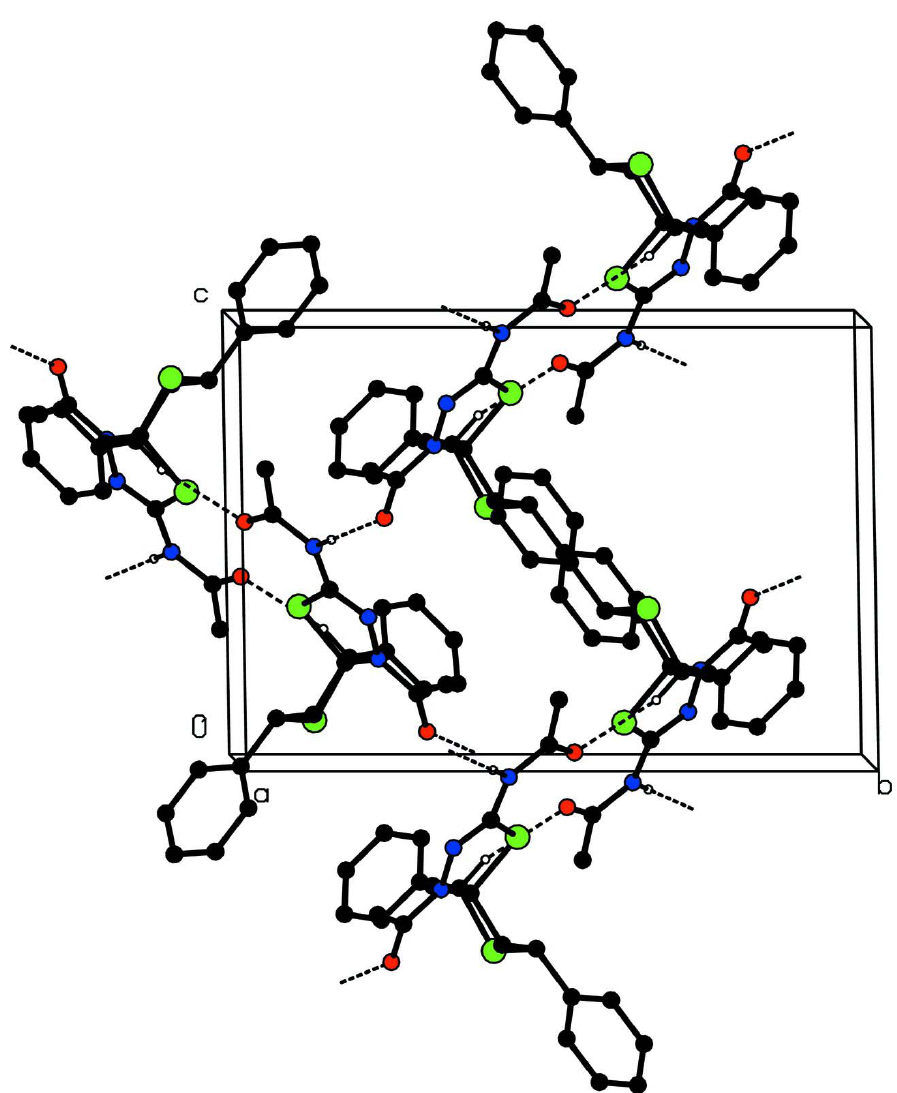
Figure 2 The packing of (I), viewed down the a axis, showing N—H···O and C—H···O intermolecular interactions. H atoms not involved in hydrogen bonding have been